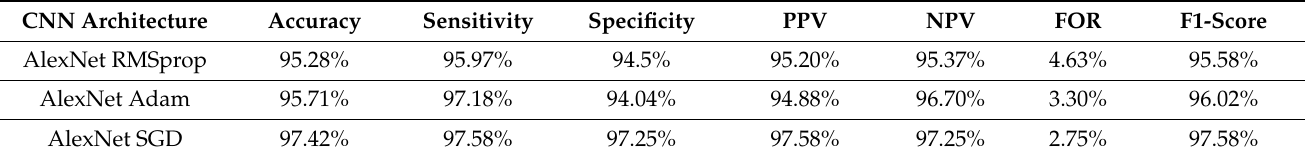
Table 5. Validation statistical analysis of the AlexNet model.